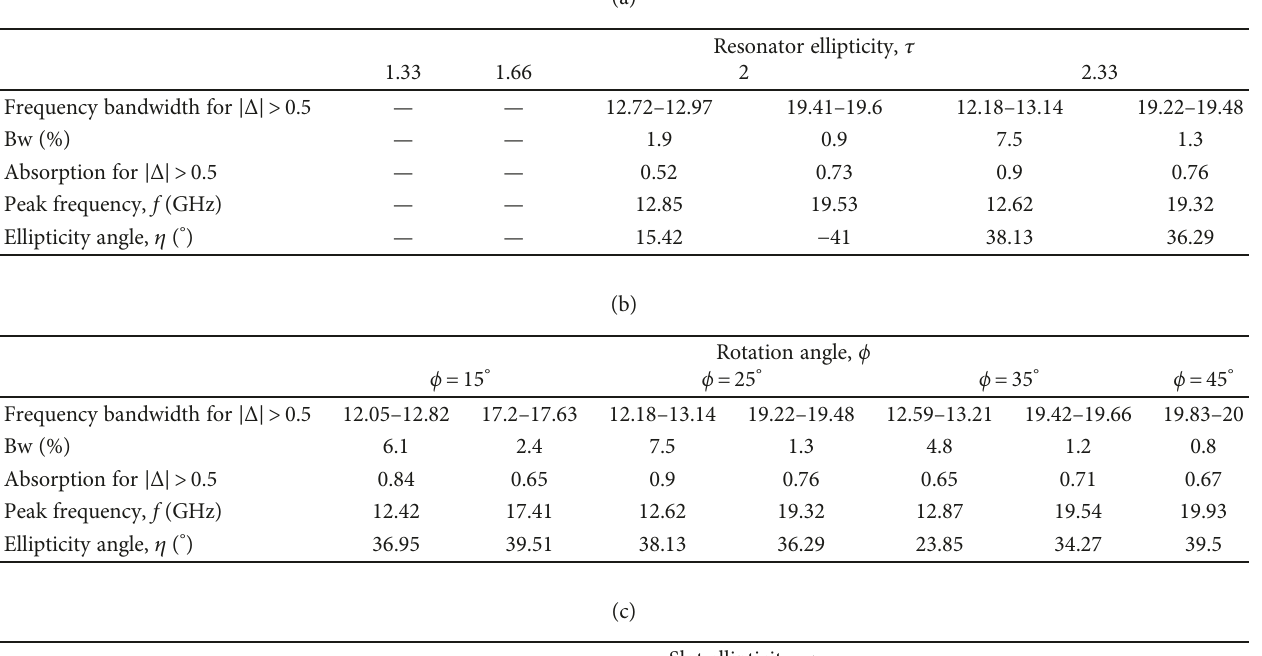
Table 1: Main data related to the e ff ects of the resonator ellipticity (a), orientation (b), and slot ellipticity (c), on the metasurface circular dichroism.